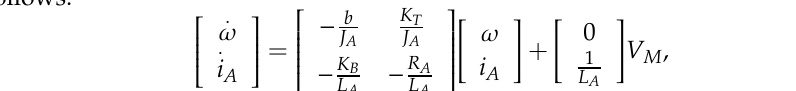
Figure 5. Je ff cott rotor Figure 5. Jeffcott rotor model.